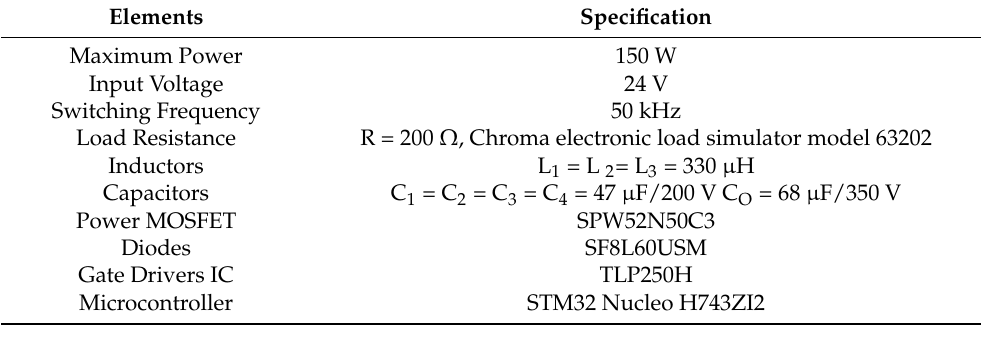
Table 5. Design specification of converter III (adapted from [31]).